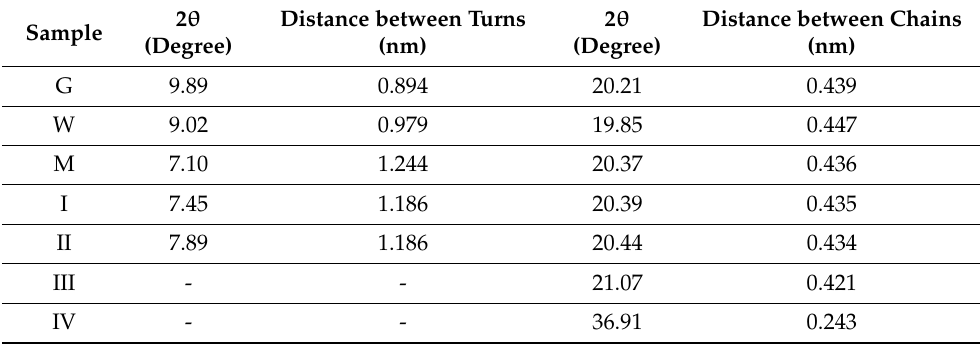
Table 3. The structural characteristics calculated from diffraction patterns for gelatin (G), whey (W), whey–gelatin (M), and whey–gelatin hydrogels crosslinked with copper (I, II, III, IV). 2 θ Distance between Turns 2 θ Distance between Chains Sample (Degree) (nm) (Degree) (nm) G